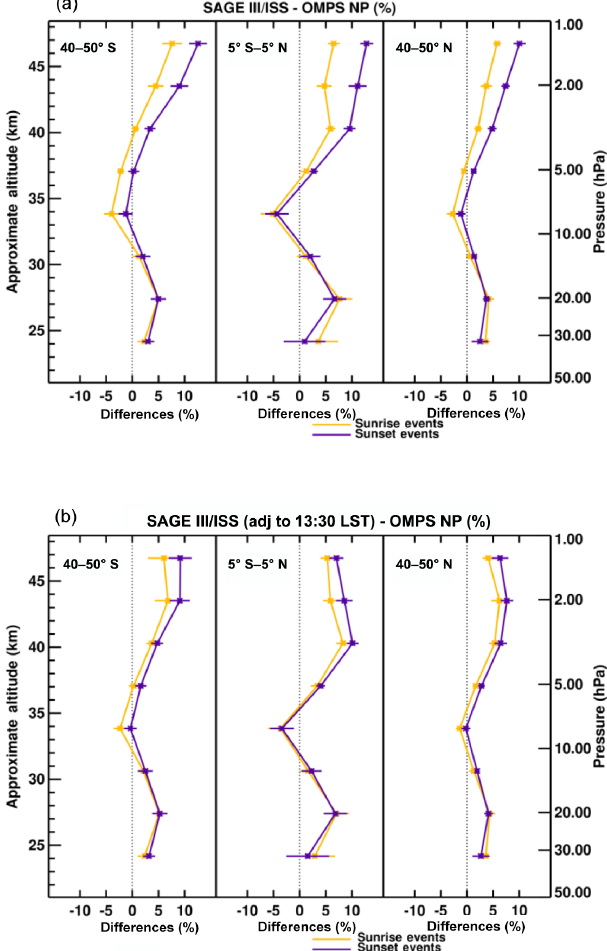
Figure 9. Profile of mean differences between SAGE III/ISS and the OMPS Nadir Profiler (percent difference) as a function of pres- sure (hPa) separated by SAGE III/ISS sunrise and sunset profiles. Panel (a) shows the original differences, and panel (b) shows the differences after the SAGE III/ISS profiles have been adjusted to the equivalent measurement time of the OMPS NP profiles. The er- ror bars represent 2SEM, based on the month-to-month variability